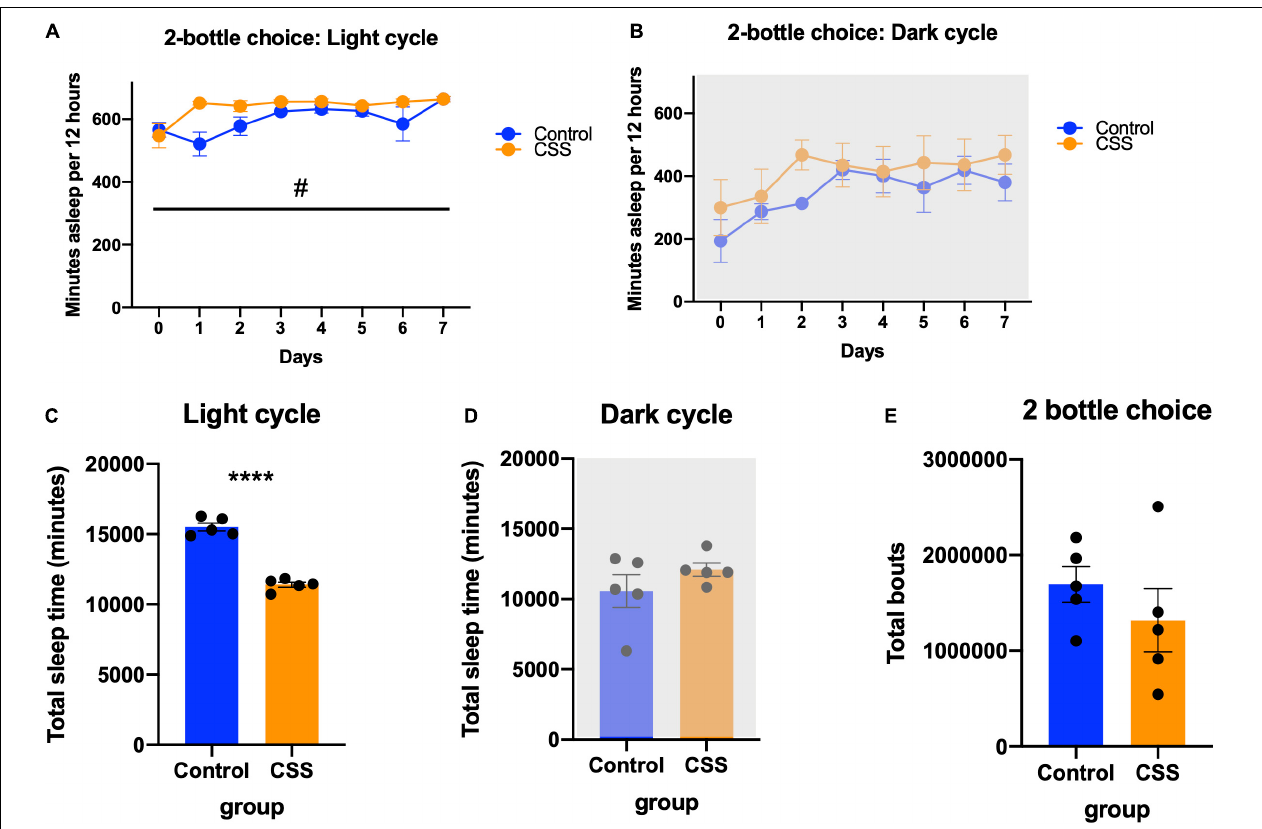
FIGURE 4 | (A) Minutes asleep per 12 h during the light (inactive) cycle during the 2-bottle choice experiment. # Denotes significant main Day × CSS interaction effect (B) minutes asleep per 12 h during the dark (active) cycle during the 2-bottle choice experiment. (C) Average bout length compared between rested and sleep deprived mice during the 2-bottle choice experiment. (D) Maximum bout length compared between control and CSS during the 2-bottle choice experiment. (E) Total bouts of sleep during the 2-bottle choice experiment. **** indicates p <